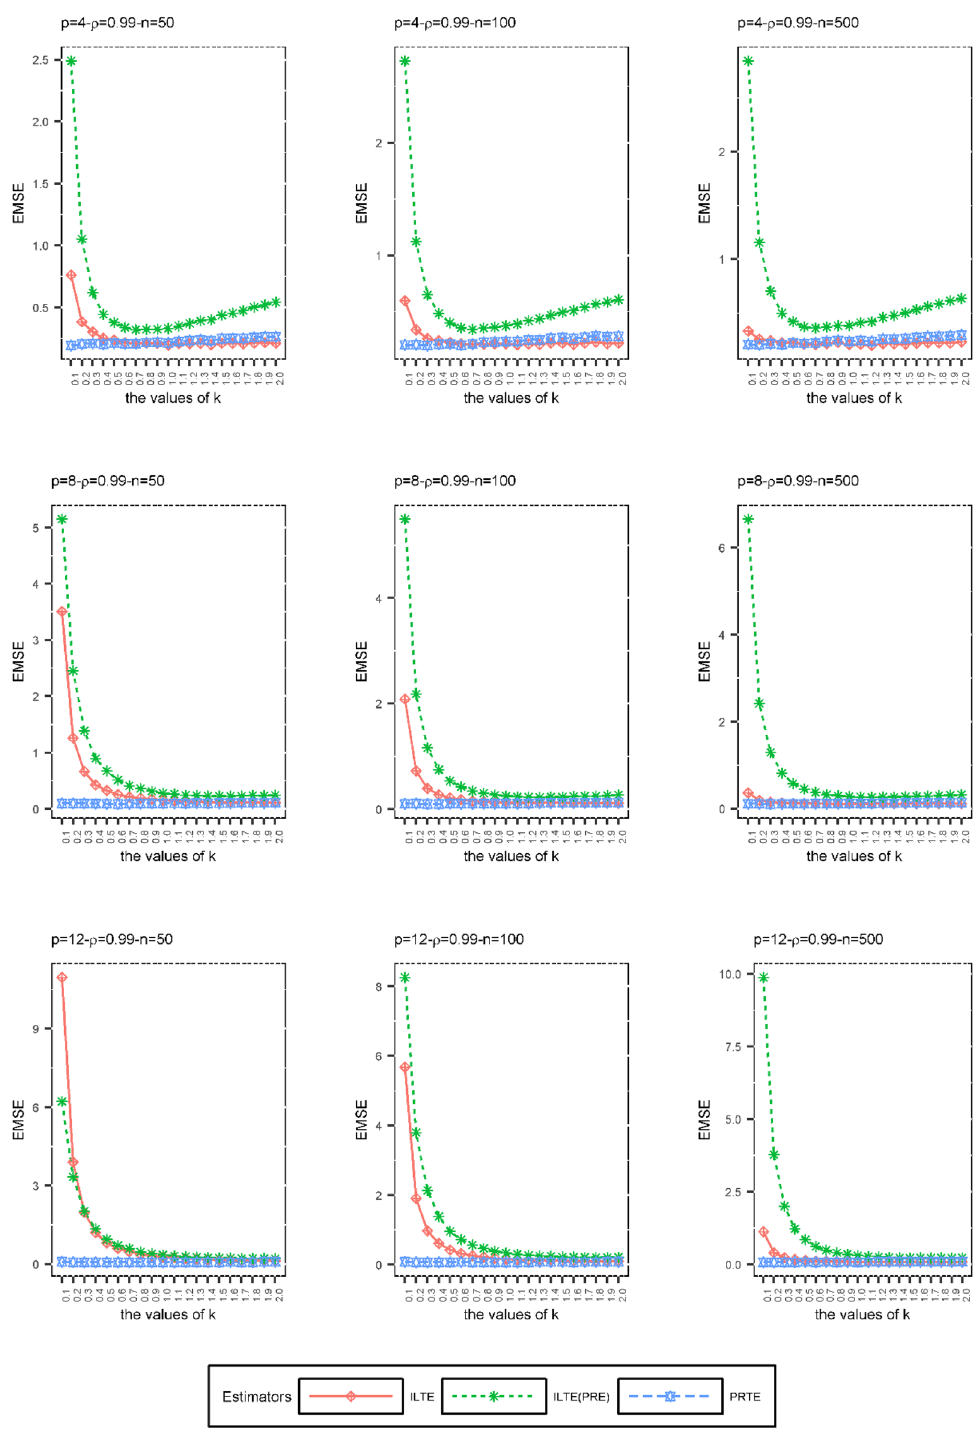
Figure 2. The EMSE values of ILTE, ILTE(PRE), PRTE as a function of k values where ρ = 0.99